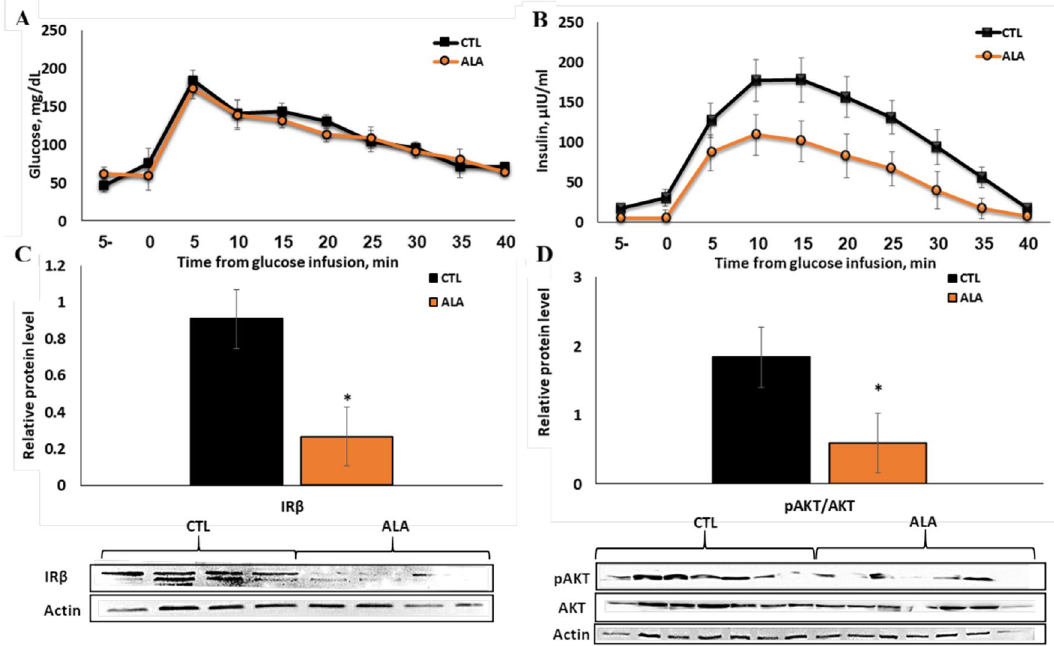
Figure 2. Response to the glucose tolerance test (GTT) in postpartum (PP) dairy cows (5–8 days PP) supplemented with n-3 during the peripartum period. Dairy cows at 257 days of pregnancy were divided into two nutritional groups supplemented with (i) CTL—encapsulated saturated fat, (ii) ALA—flaxseed supplement providing α-linolenic acid (ALA). n = 7. Time 0—Glucose infusion. ( A ) Plasma glucose concentrations during GTT; ( B ) plasma insulin concentrations during GTT; ( C ) protein abundance of insulin receptor beta (IRβ; n = 4) in insulin-stimulated AT; ( D ) phosphorylation of protein kinase B (pAkt; n = 7) in insulin-stimulated AT; two ALA samples were excluded from the analysis, one due to low protein levels and one due to ketosis diagnosed at 10 d PP. Data are presented as the mean ±